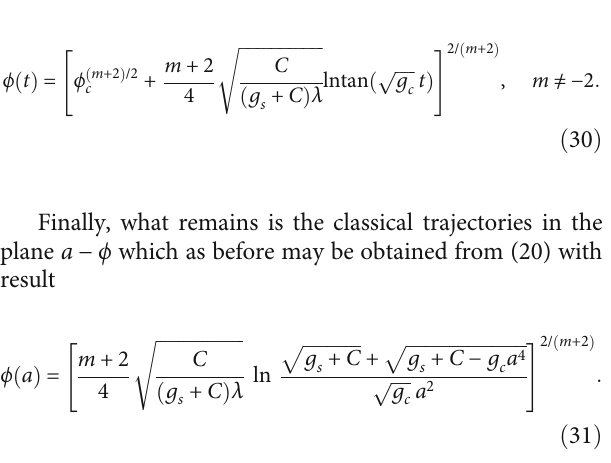
= 2 , g = 1 , C = 3 , λ = 1 , m = 2 , and ϕ c s